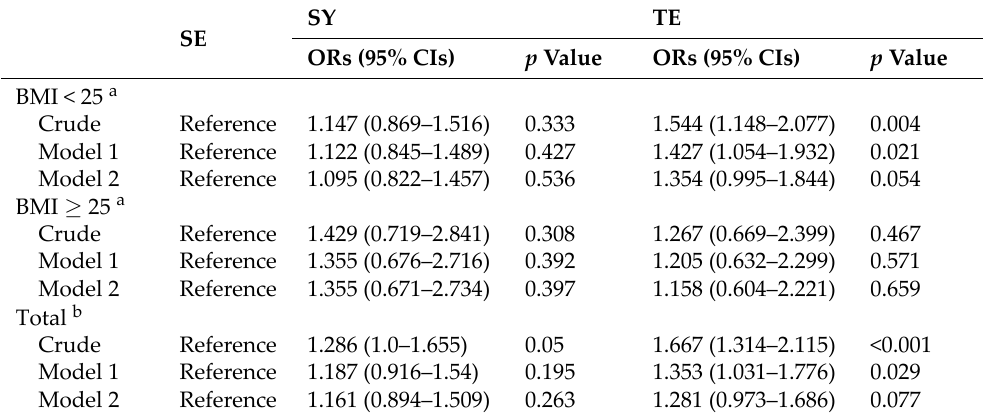
Table 3. Adjusted ORs (95% CI) of the SY and TE types compared with those of the SE type for pre- DM considering BMI.